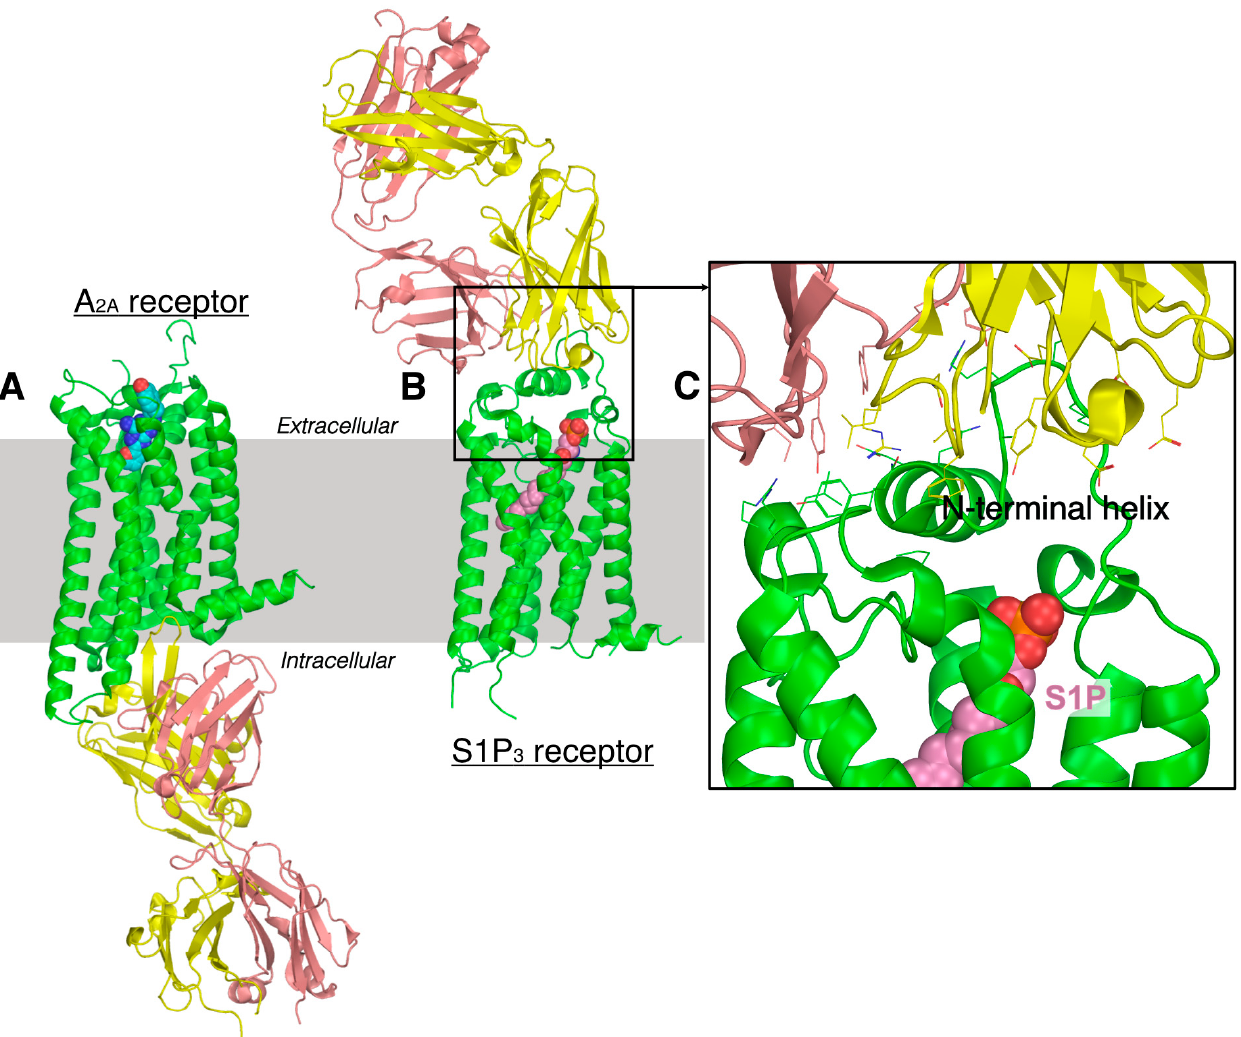
Figure 5. Molecular plots showing antibody binding to ( A ) intracellular and ( B ) extracellular epitope in A 2A adenosine (PDB ID: 3VG9) and lipid binding S1P 3 (PDB ID: 7C4S) receptors, respectively. Receptor bound ligand molecules are shown in sphere representation. Antibody heavy and light chains are shown in yellow and brown colors. ( C ) An enlarged version of antibody receptor binding site is in lipid receptor S1PR3. The interacting side chains are shown in sticks. It is noted that the antibody does interact (within 5 Å distance) with the bound ligand (shown in